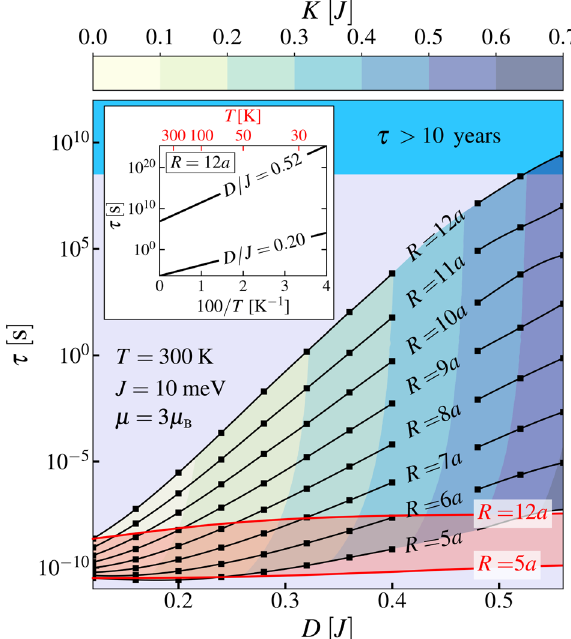
Fig. 5 Results of skyrmion lifetime calculations. Variation of the HTST-predicted skyrmion lifetime τ (black solid lines) along several contours of equal skyrmion radius R . The following values of temperature T , Heisenberg exchange parameter J and magnitude of the magnetic moments μ were assumed in the calculations: T = 300 K, J = 10 meV, μ = 3 μ B . Color codes distribution of the reduced anisotropy parameter. All calculated data points indicated by fi lled squares correspond to metastable skyrmions with respect to the FM ground state. The inset shows the Arrhenius plot for the two values of the reduced DM interaction parameter on R = 12 a isoline. The magnitude of the lifetime calculated in the constant Arrhenius prefactor approximation is within the pink area for all skyrmion radii from 5 a to 12 a . Blue area indicates lifetimes greater than 10